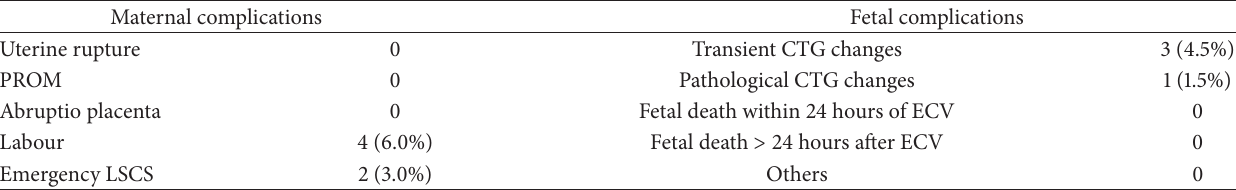
Table 2: Complications occurring within 24 hours of external cephalic version (ECV).